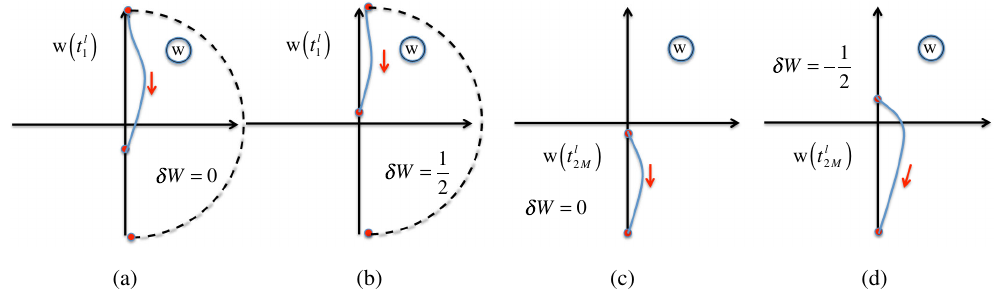
FIG. 10. The contribution from the first- and the last-intersecting points to the winding number of the contour. Parts (a) and (b) represent contributions from the first intersection. Parts (c) and (d) are contributions from the last